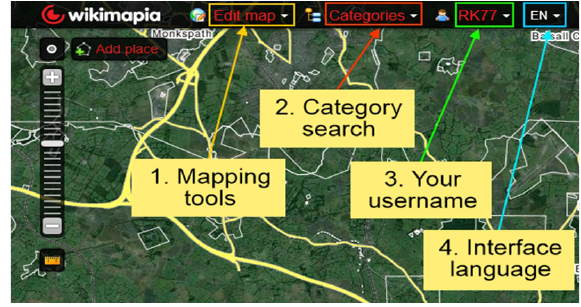
Figure 2. Figure Wikimapia Interface